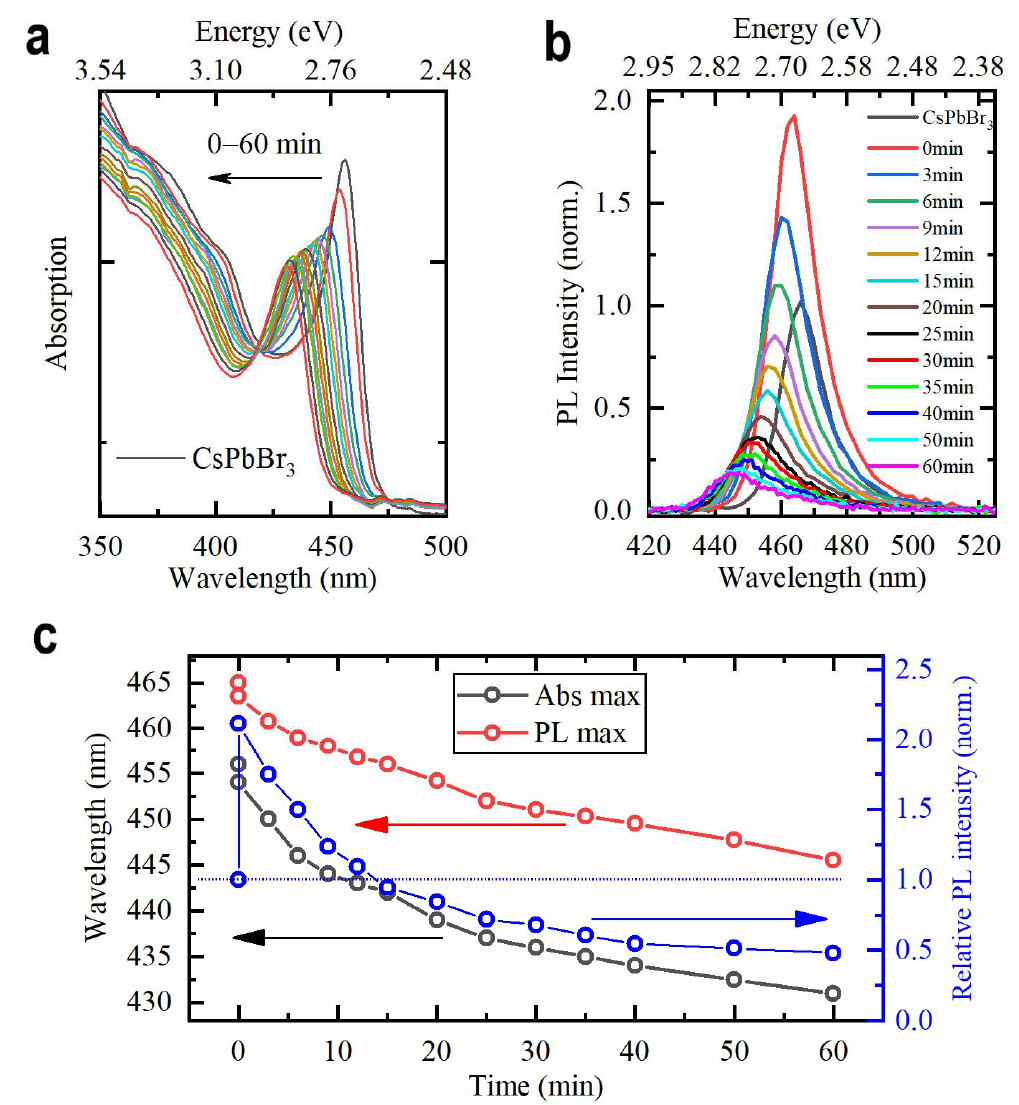
Figure 2. Evolution of ( a ) absorption and ( b ) PL spectrum under Cd 2+ doping. ( c ) Evolution of absorption and PL peak positions and relative PL intensity.